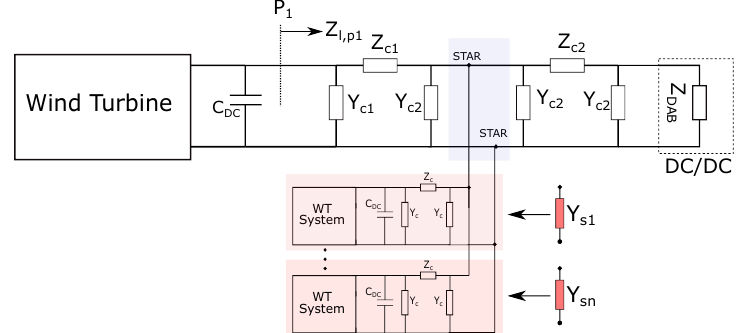
Figure 17. Multiple wind turbines in star configuration.